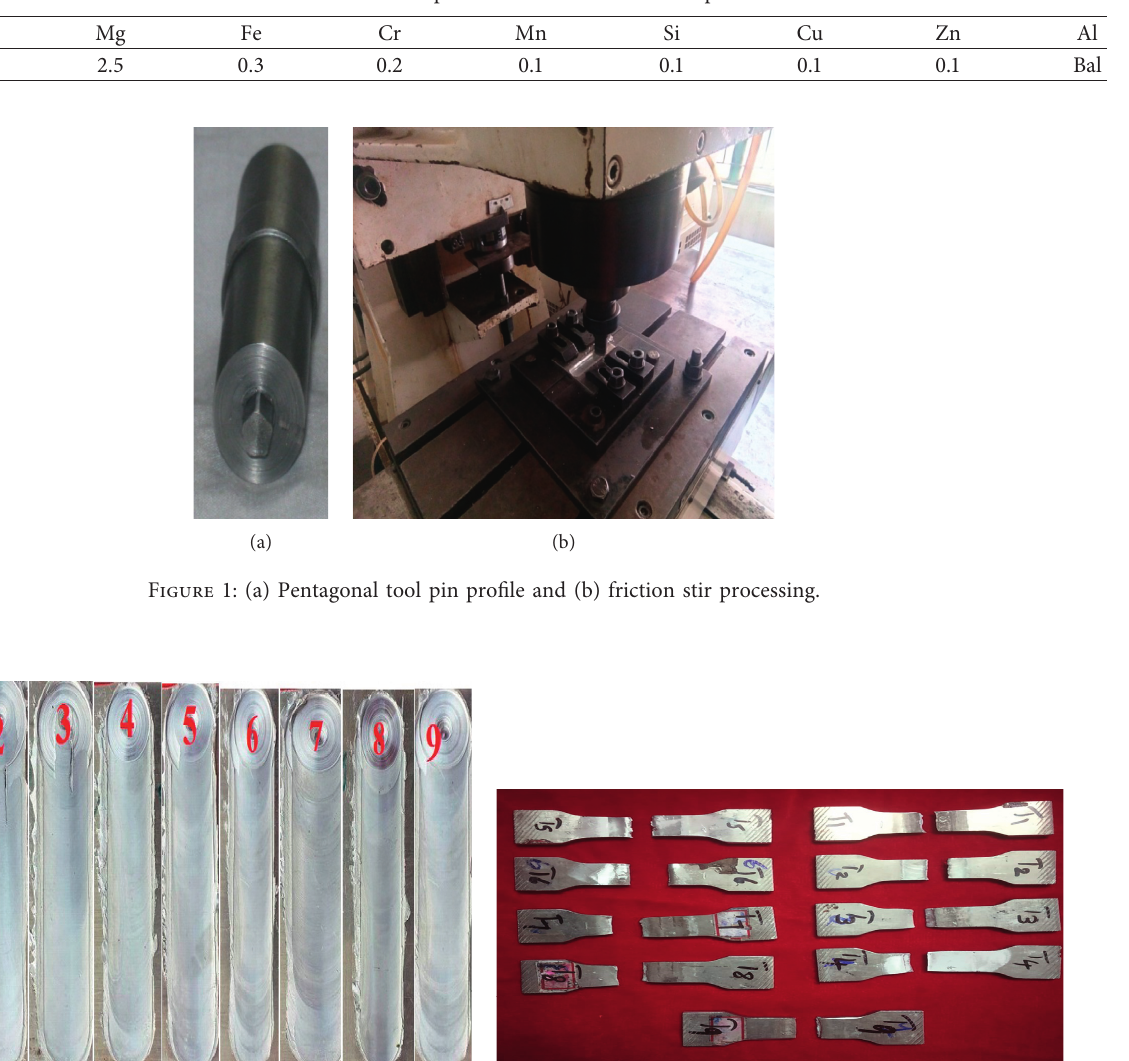
Table 1: Chemical composition of the AA5052 base plate.